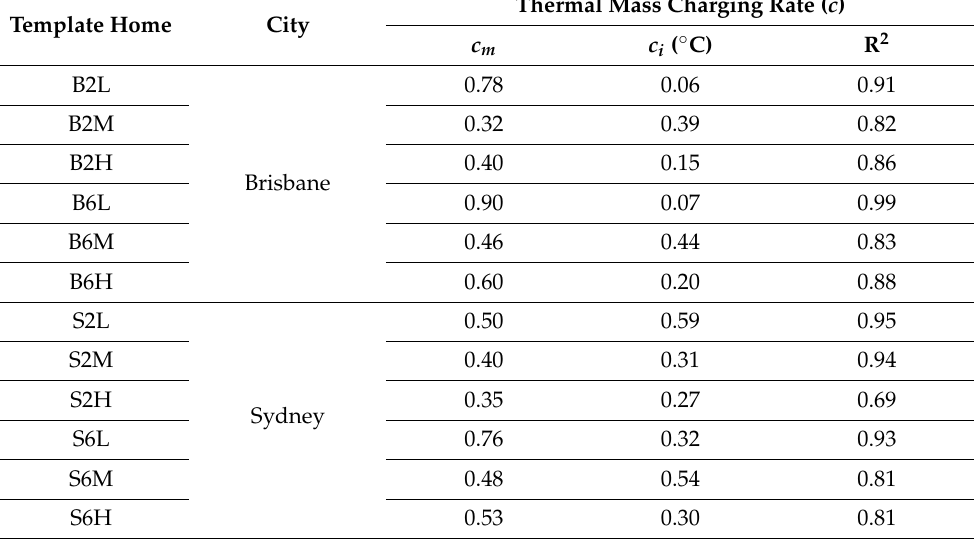
Table A3. Thermal mass charging